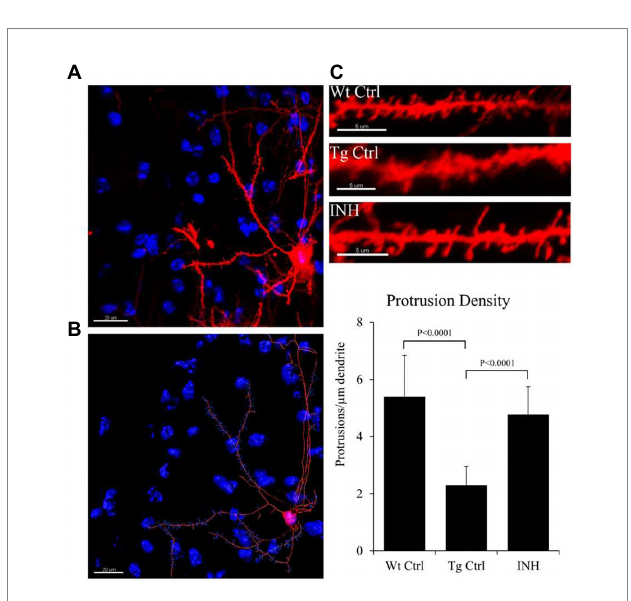
FIGURE 5 (A–C) INH increases the density of dendritic spines in the brains of APP/PS1 mice. Representative images of the DiOlistic labeling of a single neuron from the brains of each group were shown. The bar chart showed the quantitative result of the density of dendritic